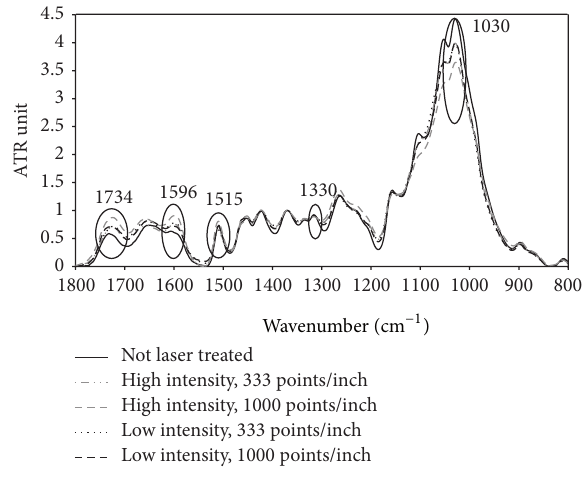
Figure 5: FTIR spectra of spruce wood before and after various laser beam